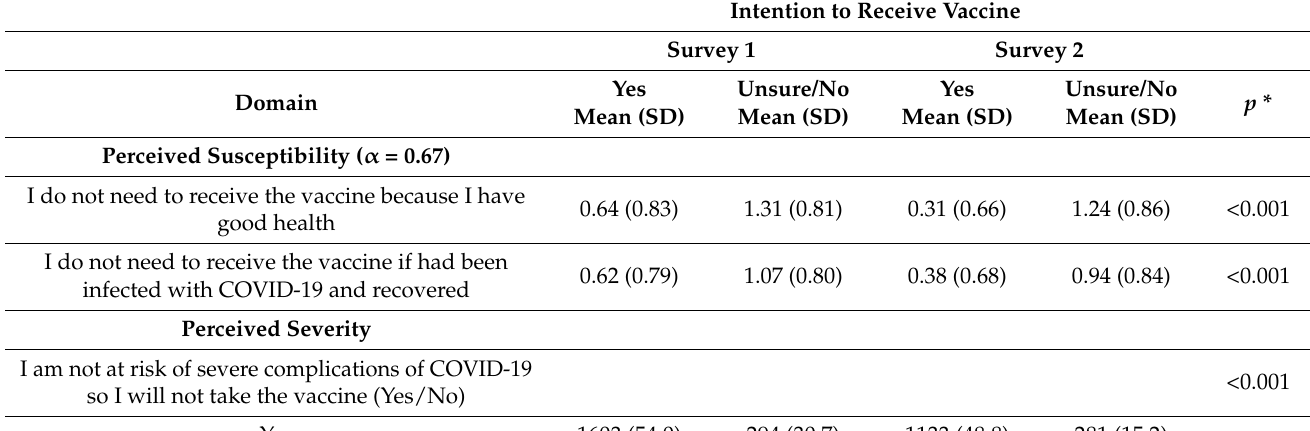
Table 2. Items, response scales, and internal consistency for HBM domains and knowledge